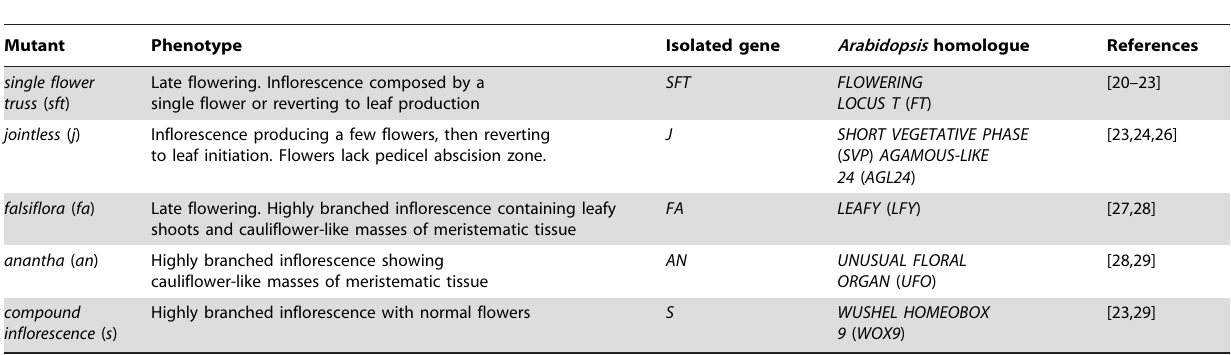
Table 1. Some mutations affecting flowering in